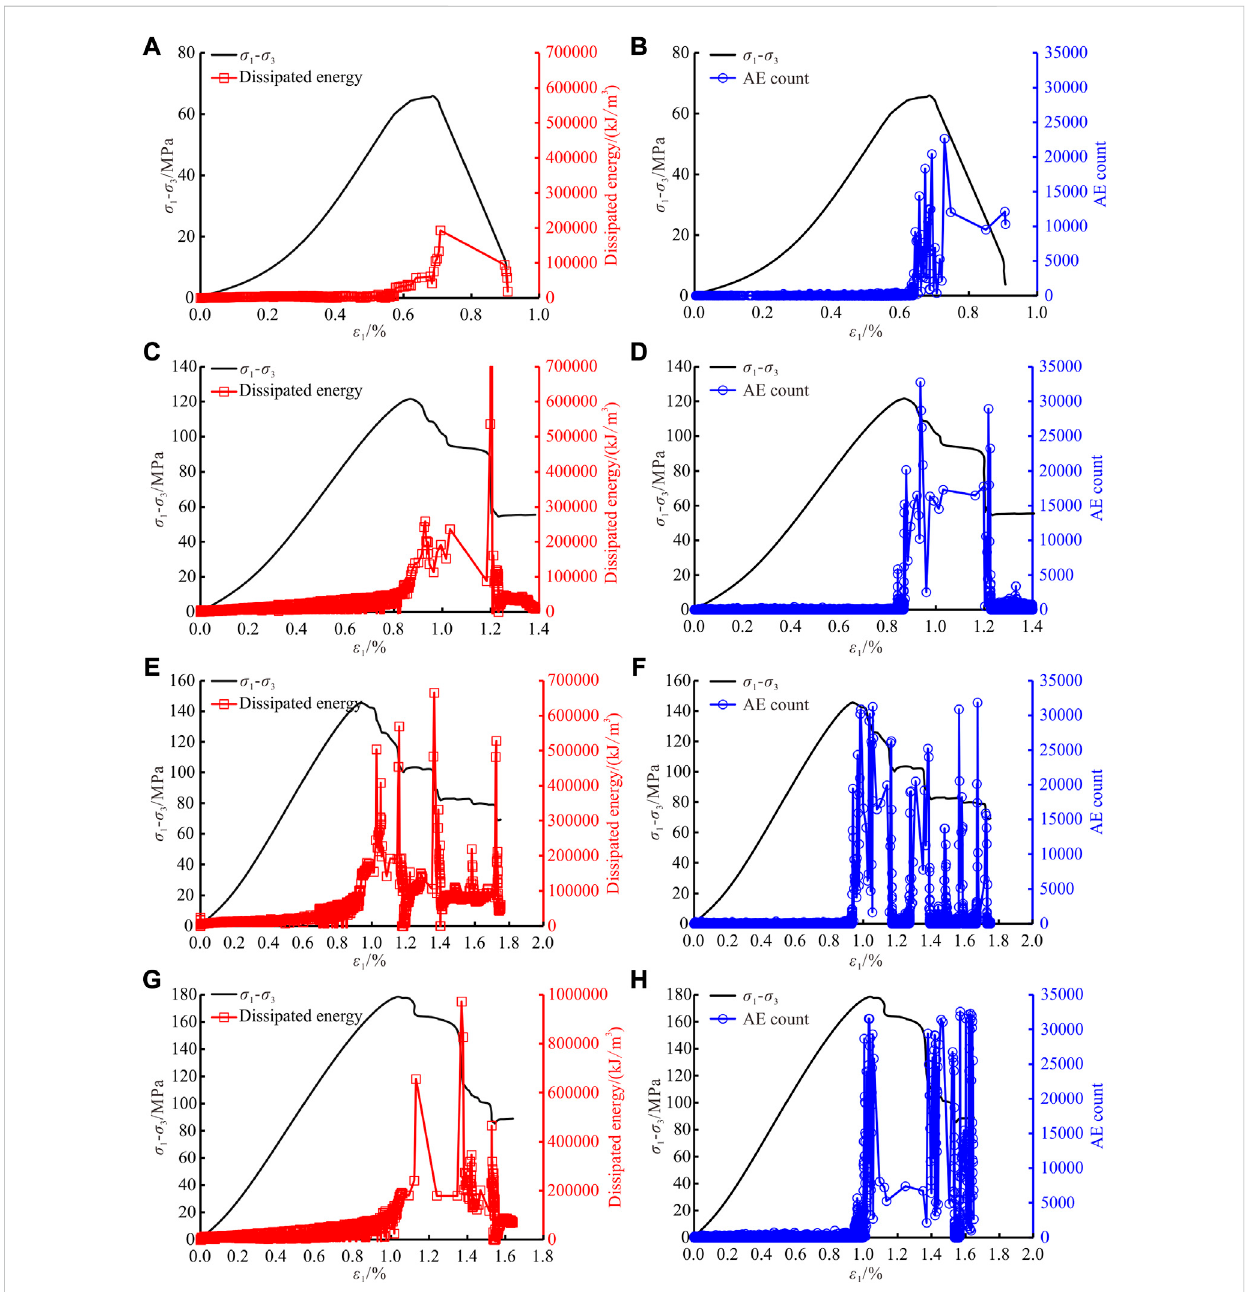
FIGURE 12 Evolution characteristics of dissipated energy and AE count. (A) Dissipated energy under σ 3 = 0 MPa. (B) AE count under σ 3 = 0 MPa. (C) Dissipated energyunder σ 3 = 5 MPa. (D) AEcount under σ 3 =5 MPa. (E) Dissipatedenergy under σ 3 =10 MPa. (F) AEcount under σ 3 = 10 MPa. (G) Dissipated energy under σ 3 = 15 MPa. (H) AE count under σ 3 = 15